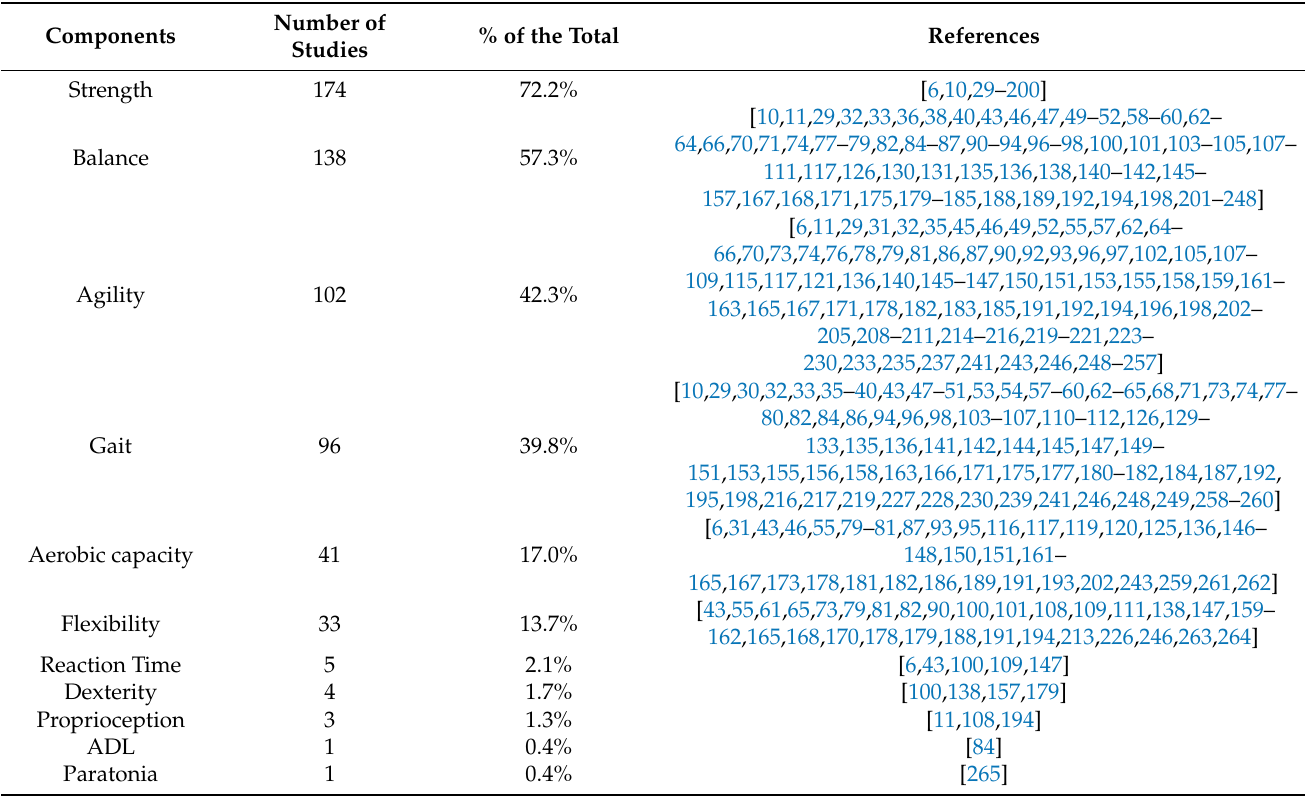
Table 1. Physical/motor components that were identified in the reviewed